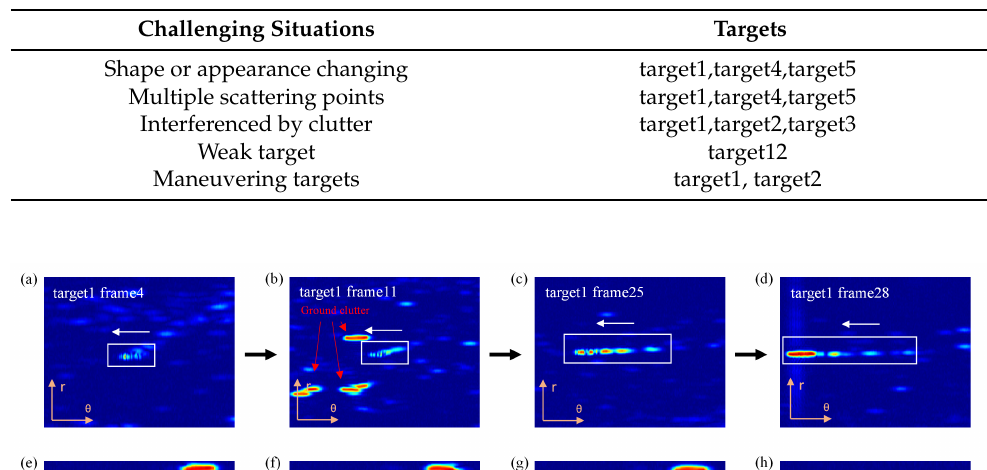
Table 8. Some challenging targets in monitor scenarios.